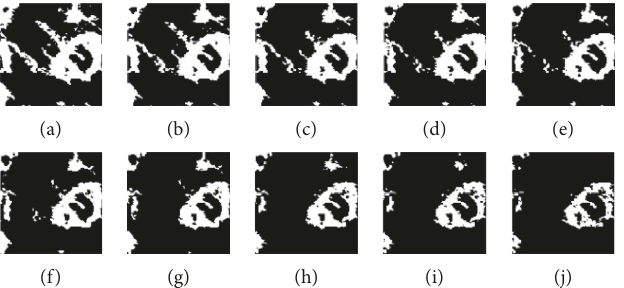
Figure 13: Wood vessels’ peripheral region extraction with different k values. (a) k � 2, (b) k � 7, (c) k � 12, (d) k � 17, (e) k � 22, (f) k � 27, (g) k � 32, (h) k � 37, (i) k � 42, and (j) k �